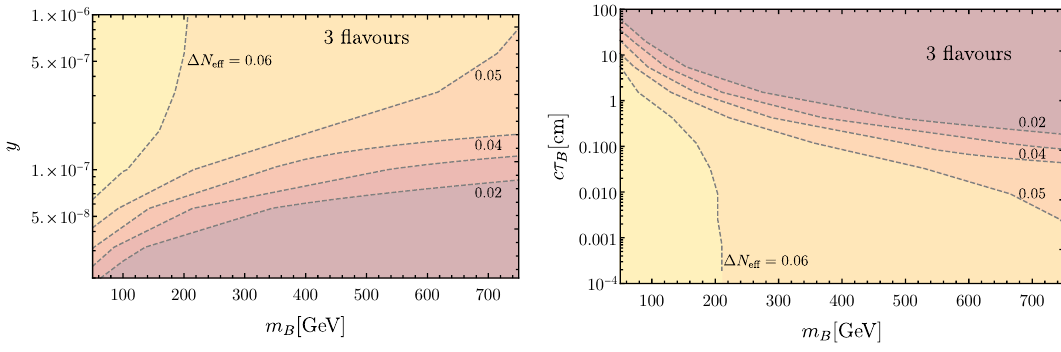
Figure 2 . Shift in the effective degrees of freedom as a function of the mass and coupling ( left ) or proper decay length ( right ). Shorter lifetimes correspond to larger coupling and for short enough lifetimes we reach the equilibrium densities and the upper bound on ∆ N